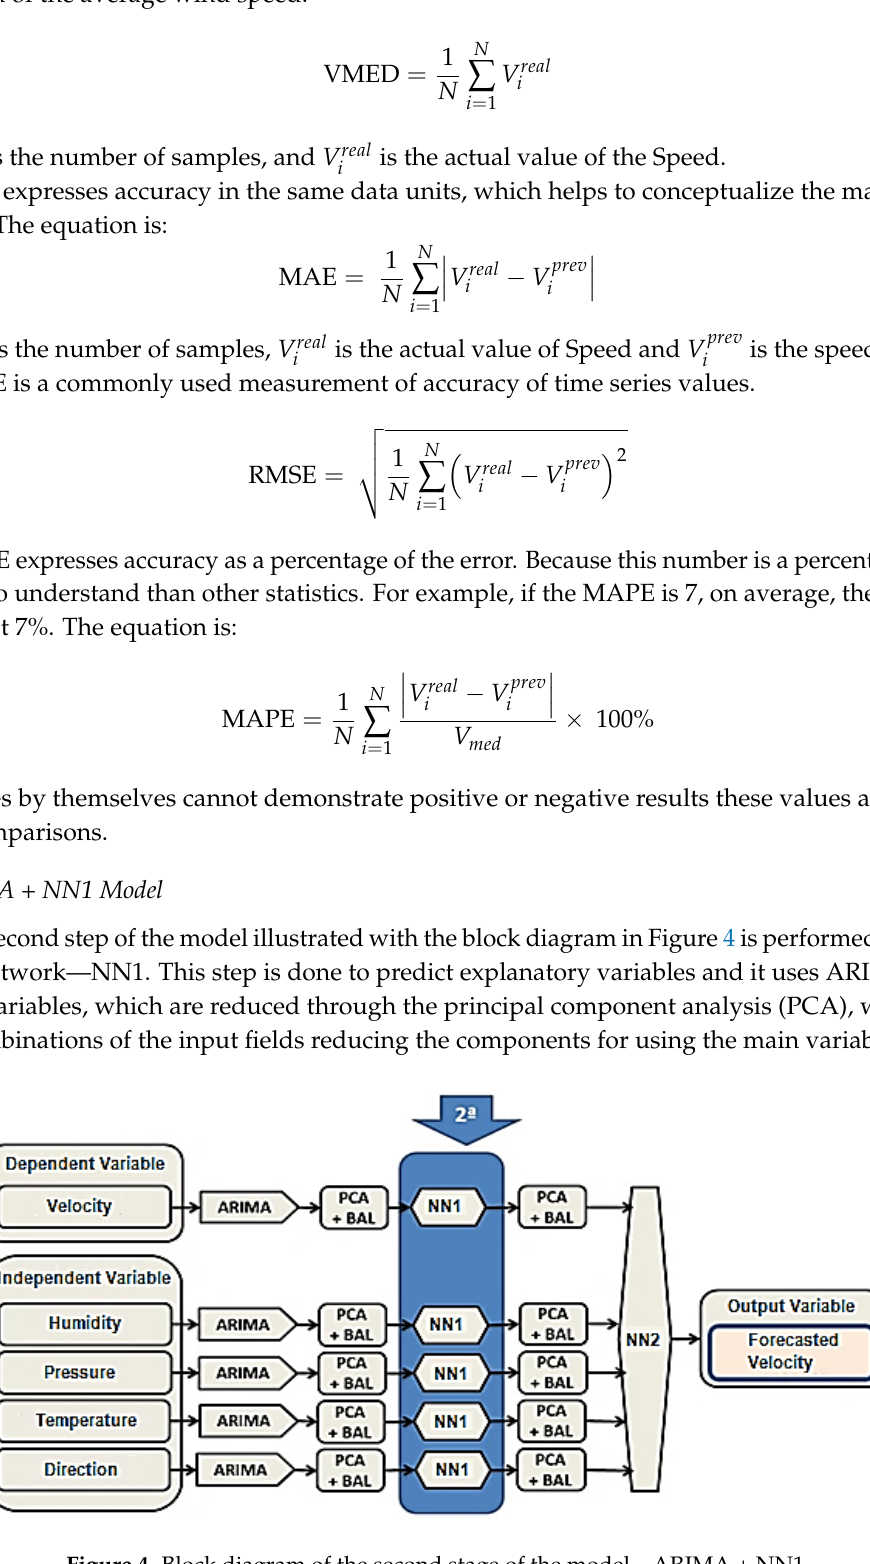
Figure 4. Block diagram of the second stage of the model—ARIMA + NN1.